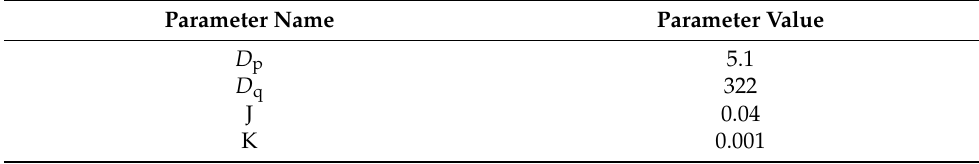
Table 2. VSG controller parameters.